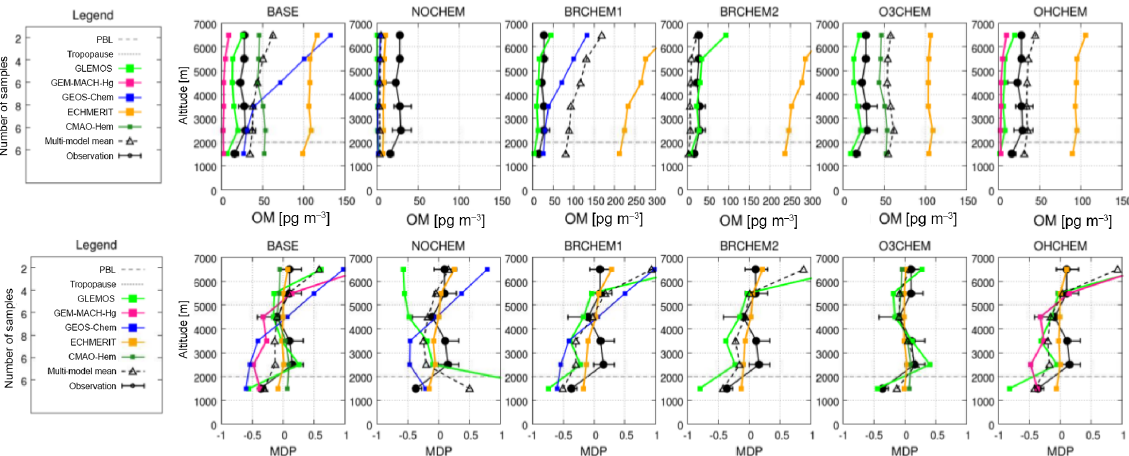
Figure 8. GOM + PBM with observations at Tullahoma, TN, for January and February 2013 reported by Brooks et al. (2014). The error bars indicate the 66% quantile range of the observations in each altitude; the sample size for each altitude is indicated on the y axis of the